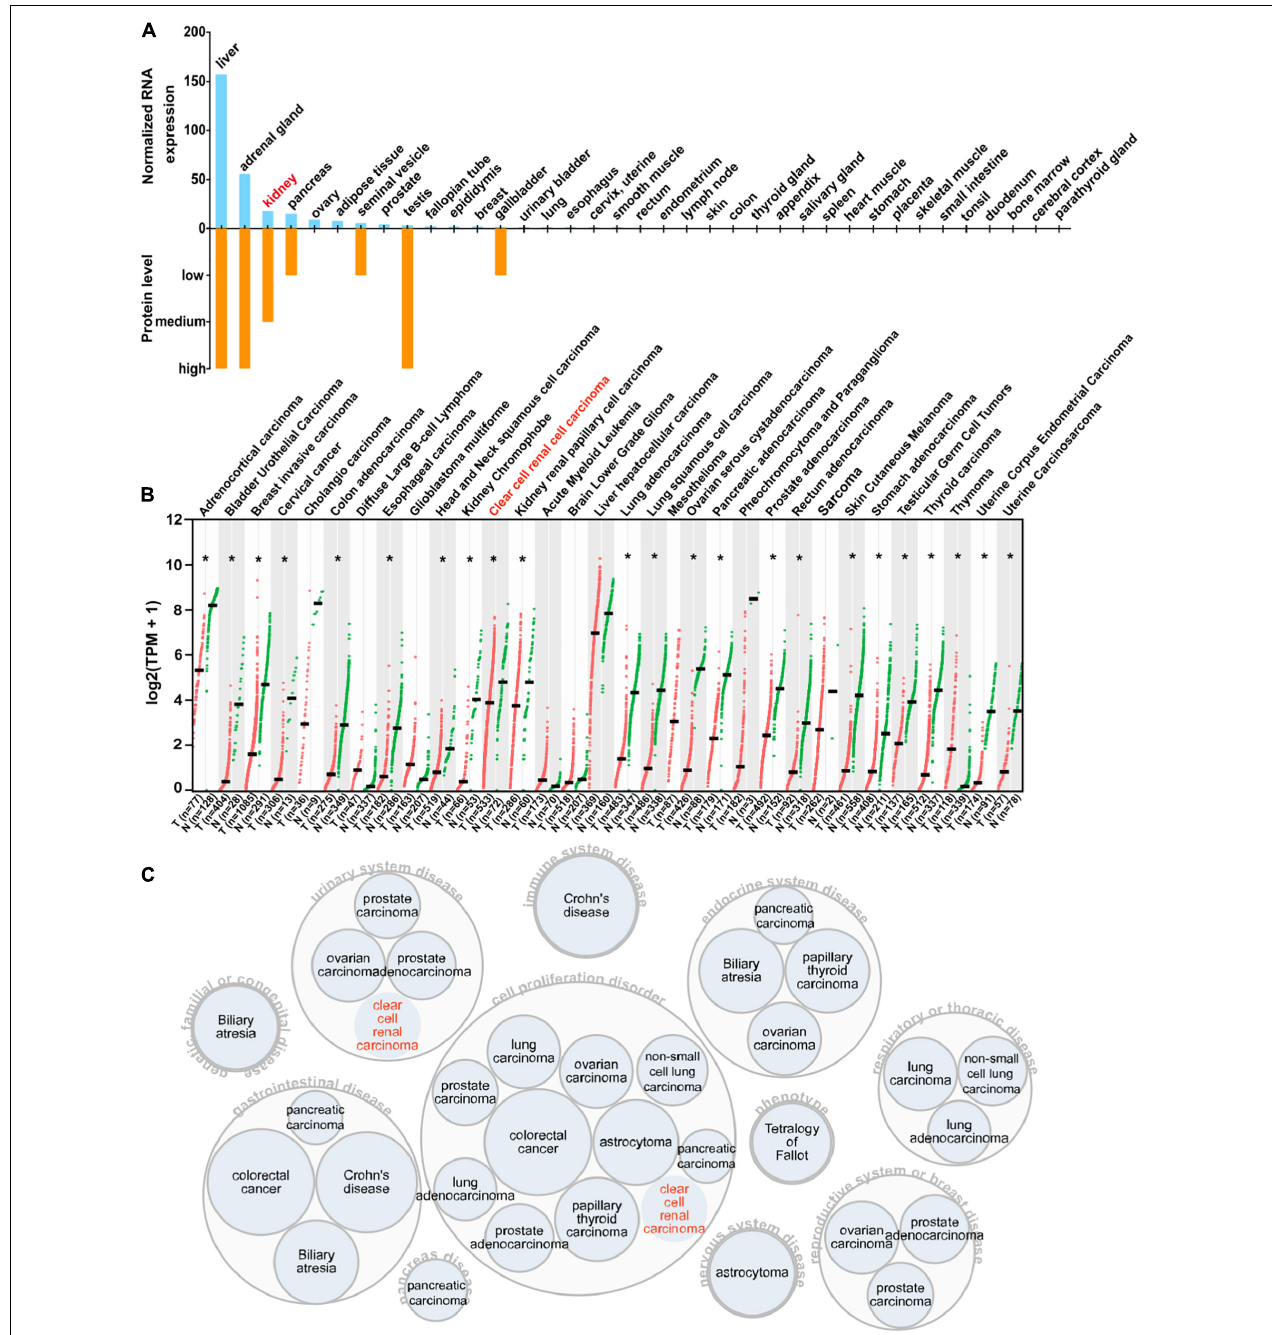
FIGURE 7 | Expression profile of AOX1. (A) Bar graph depicting AOX1 mRNA and protein expression in 37 human tissues in the Human Protein Atlas (HPA) database. (B) Comparison of AOX1 expression in 31 different kinds of cancers and matched normal control samples. T stands for tumor, and N stands for normal. Clear cell renal cell carcinoma (ccRCC) patient data were extracted from The Cancer Genome Atlas Kidney Renal Clear Cell Carcinoma (TCGA-KIRC) using UCSC Xena. * p < 0.05. (C) Target–disease association analysis revealing AOX1-associated